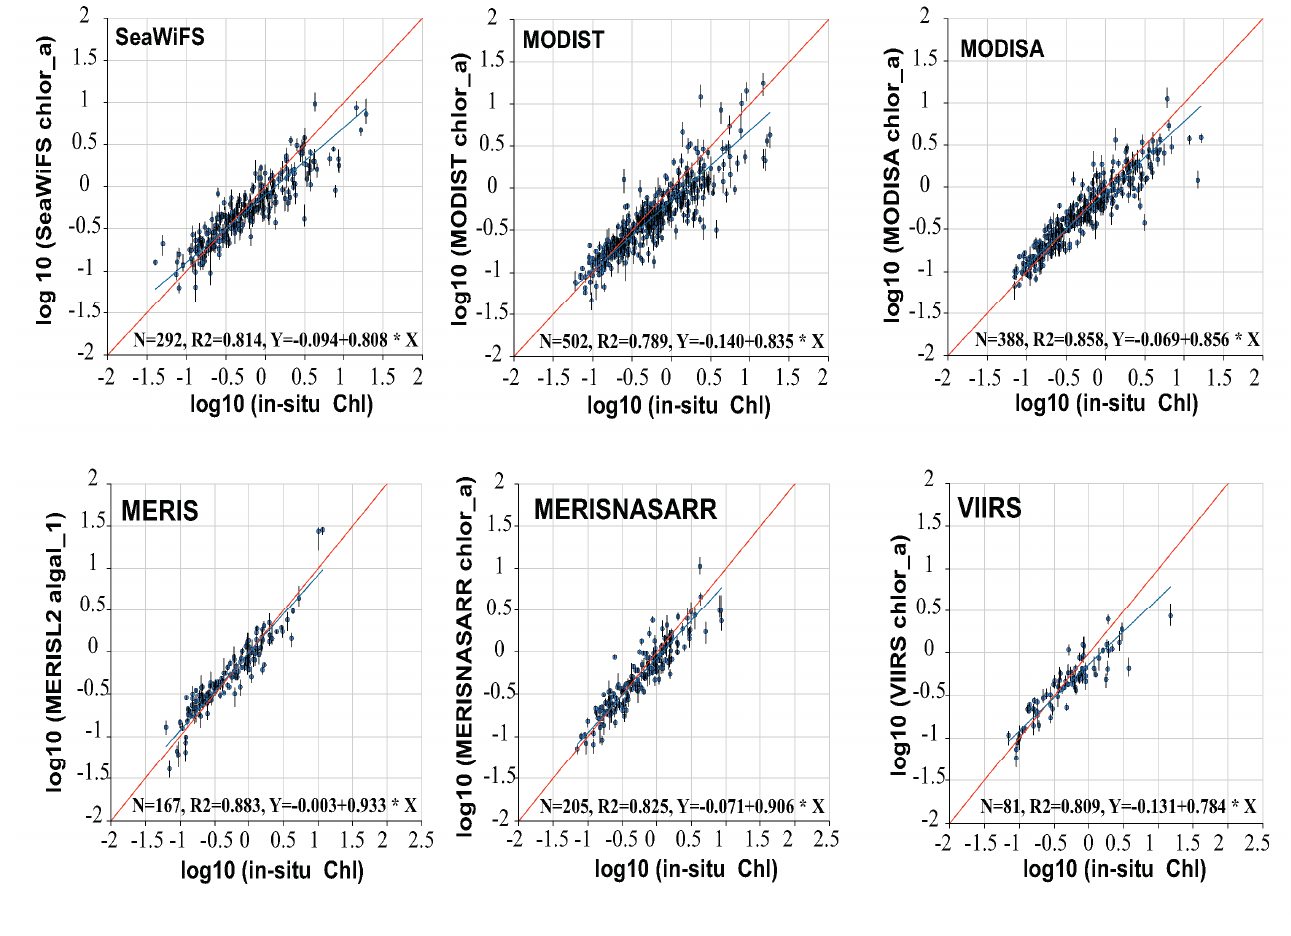
Figure 3. Chlorophyll-a match-ups with individual sensors/products using standard algorithms. The maximum allowed time difference is 3 h, and at least five pixels out of nine are required to be valid. The red line is the one-to-one line, and the blue line is the reduced major axis linear regression.